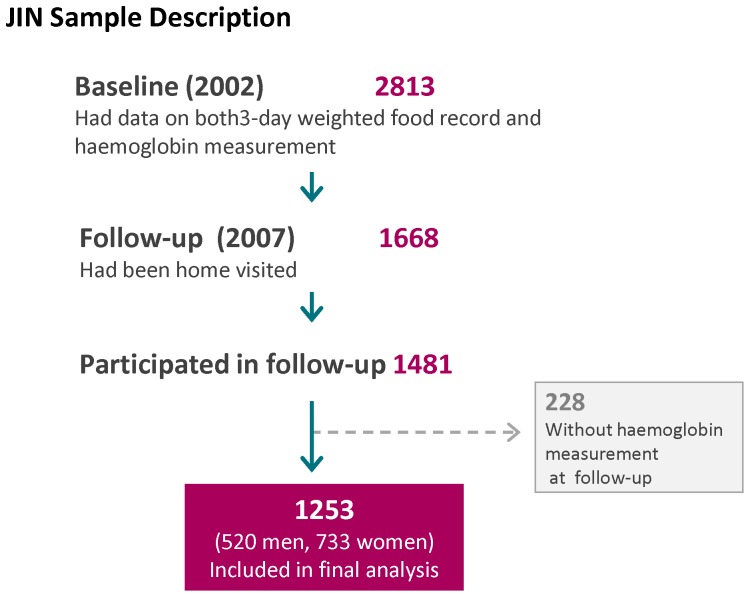
Sample description.